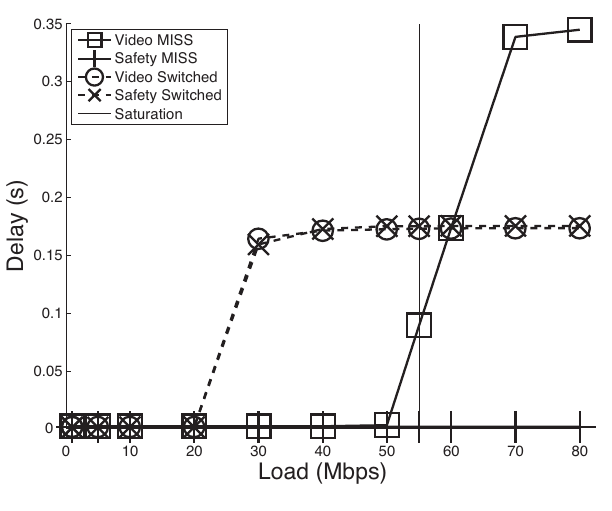
Figure 11. Delay vs. Load Comparison